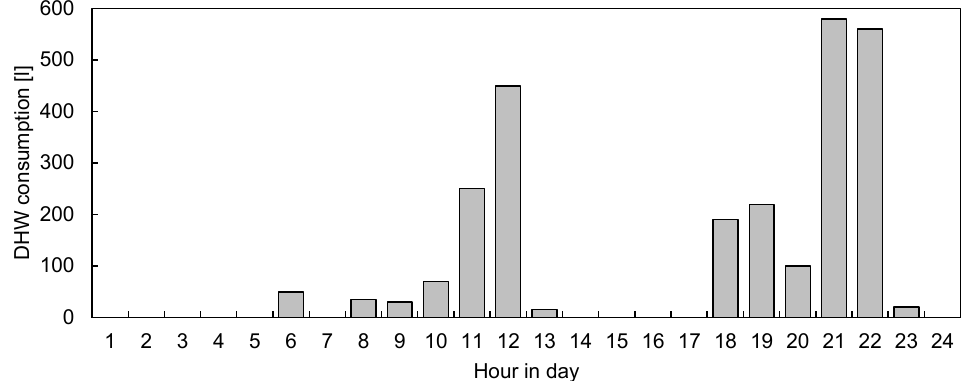
Figure 5. DHW consumption profile for a standard day in a year.